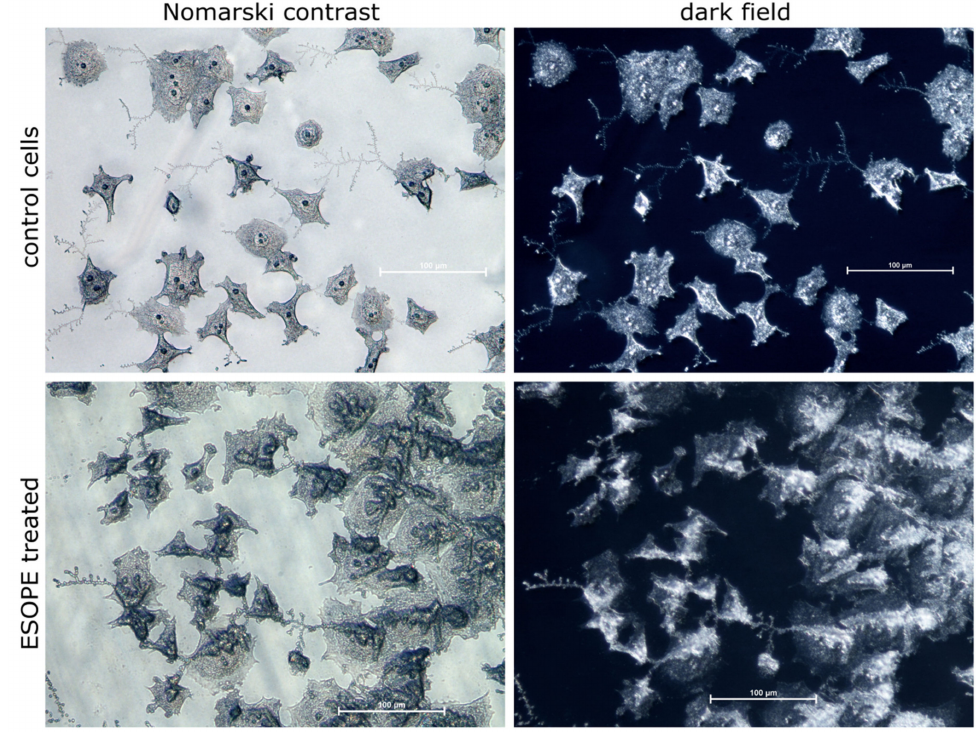
Figure 8. Visualization of morphology by Nomarski interference contrast microscopy of control MCF-7 / WT cells and after application of electrical pulses (ESOPE parameters) within 24 h of